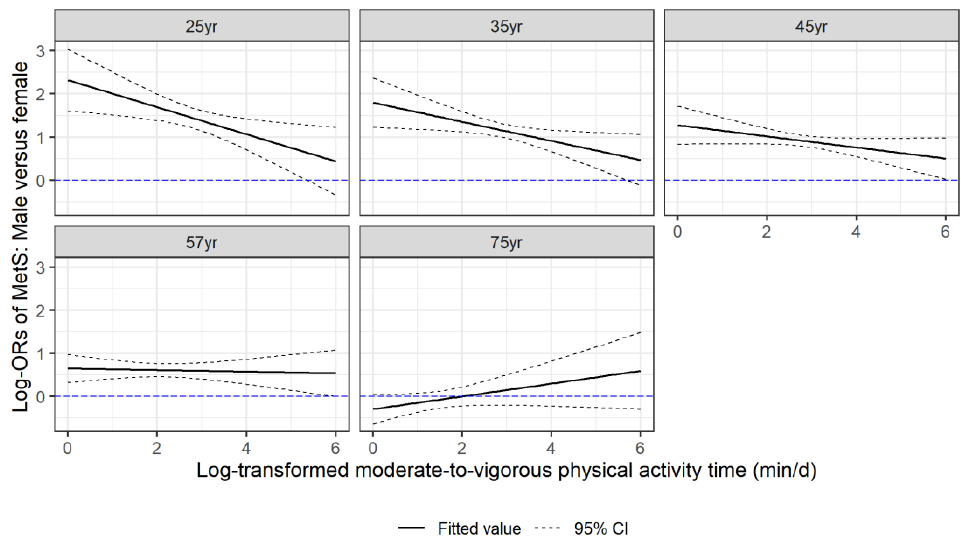
Figure 4. Adjusted association between sex and MetS according to log-transformed MVPA time at different age. Y axis is the predicted log e (OR) of MetS in males compared to females in a logistic regression model with sex, age, log e (MVPA + 1), and their two-way and three-way interactions and adjusted for race/ethnicity (White, Mexican American, Other Hispanic, Black, and others), BMI, smoking status (never, former, and current), drinking status (non-drinker, moderate drinker, and heavy drinker), and total daily energy intake. Each panel presents the relationship in the population of participants at the median age of each of the age